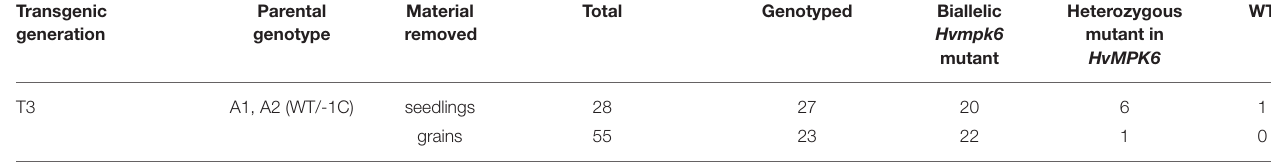
TABLE 4 | Characterization of the plant material removed from the soil of pots with no plant emergence. Transgenic generation